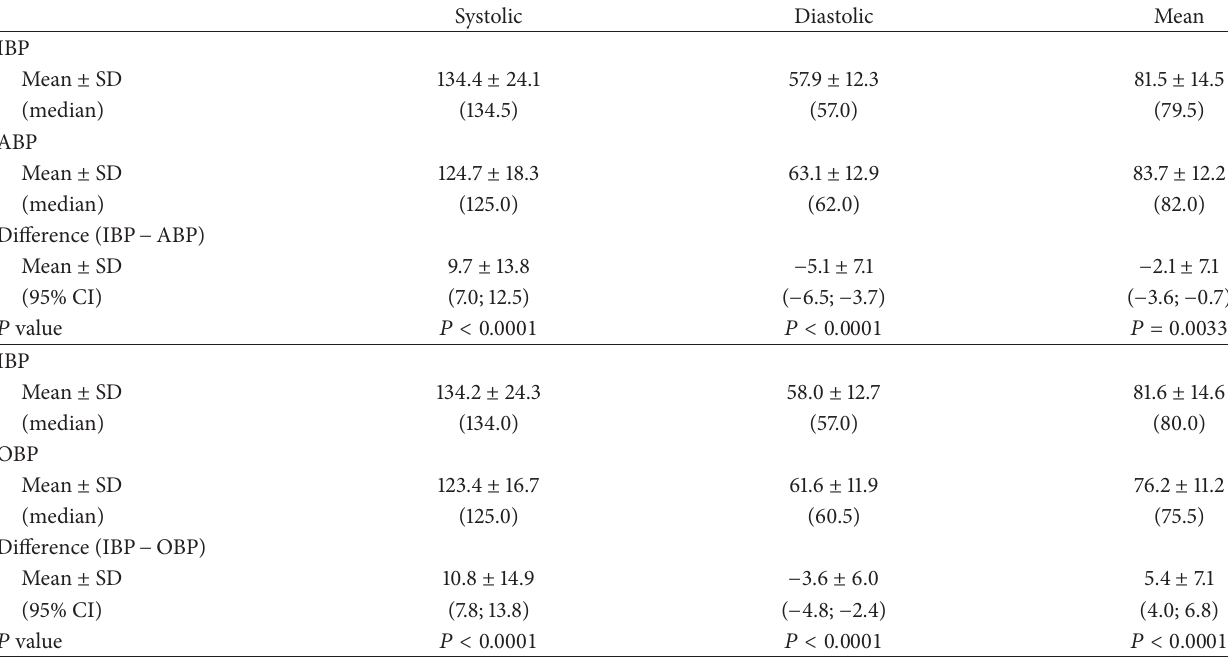
Table 1: Differences between patient systolic, diastolic, and mean arterial pressure taken with direct-invasive (IBP) and, respectively, with auscultatory-aneroid (ABP) and oscillometric automated (OBP) methods.